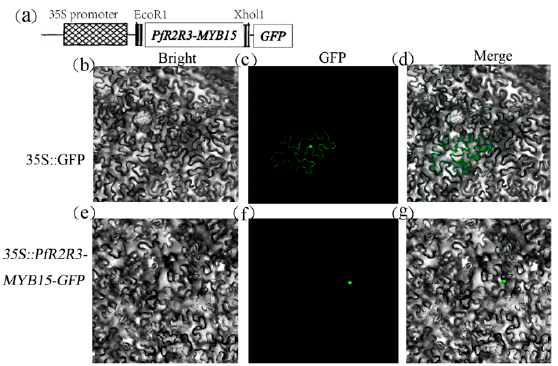
Figure 7. Subcellular localization of PfR2R3-MYB15 . ( a ) Diagram of the 35S promoter and GFP in PfR2R3-MYB15 . ( b – g ) 35S:: PfR2R3-MYB15-GFP and 35S::GFP were transferred into N. benthamiana .